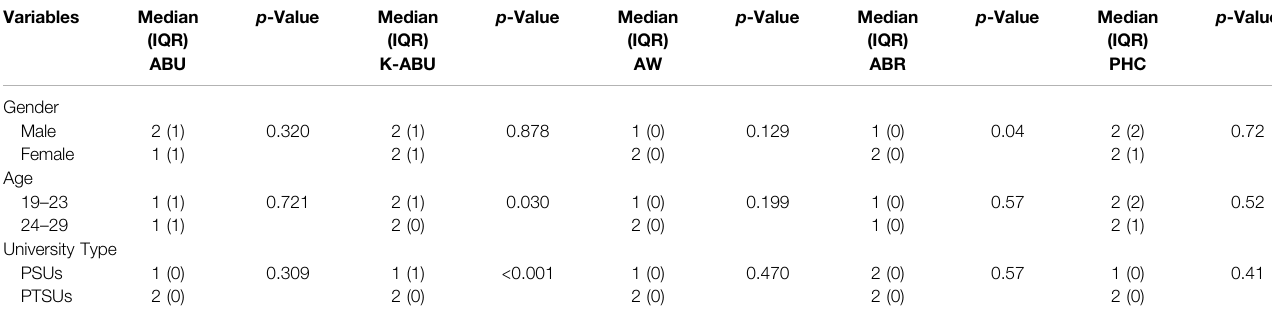
TABLE 6 | Median scores of related antibiotics knowledge, antibiotics use, awareness of terminologies, ABR, and pharmacy syllabus.